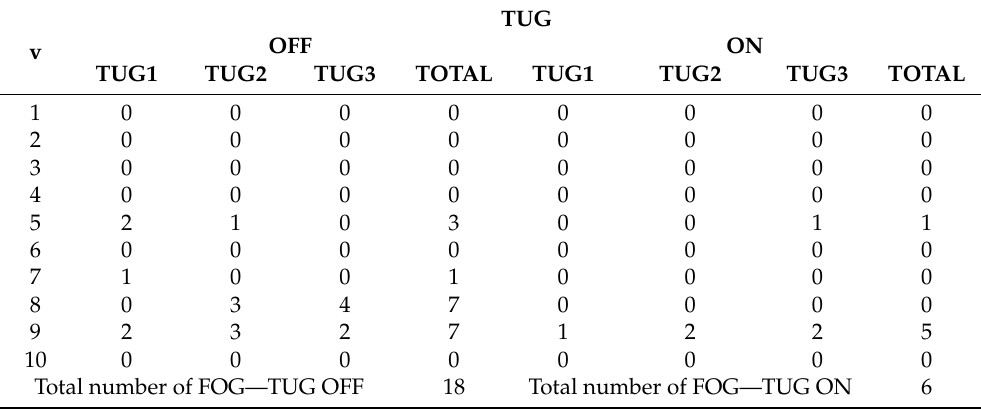
Table 3. Number of FOG episodes for each volunteer and the total number of FOG episodes during the OFF- and ON-medication states for the TUG test.